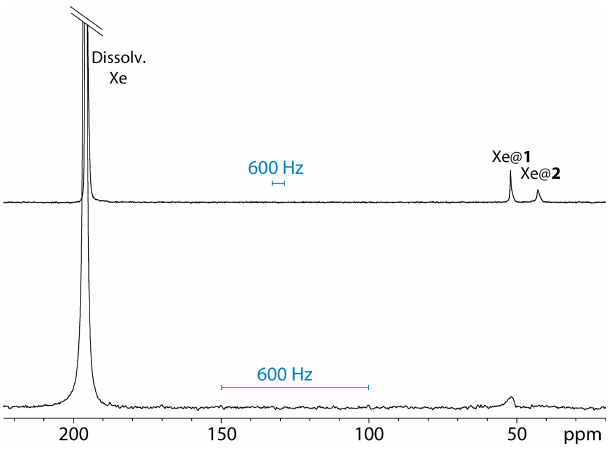
Figure 3. One-scan 129 Xe NMR spectra of the noble gas into a water solution of cryptophanes 1 and 2, both at 77µM and 295K, with the same pulse flip angle. Top spectrum performed at 11.7T; bottom spectrum performed at